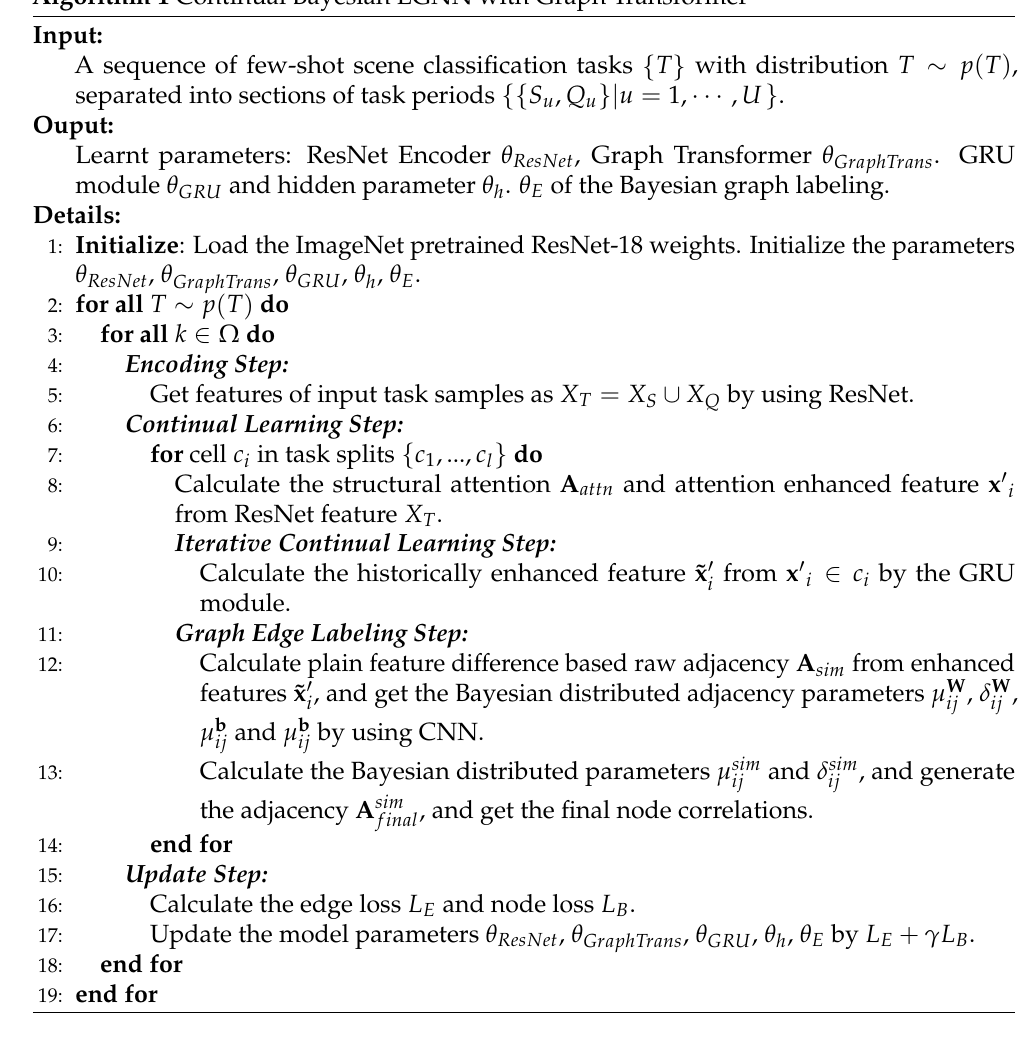
Algorithm 1 Continual Bayesian EGNN with Graph